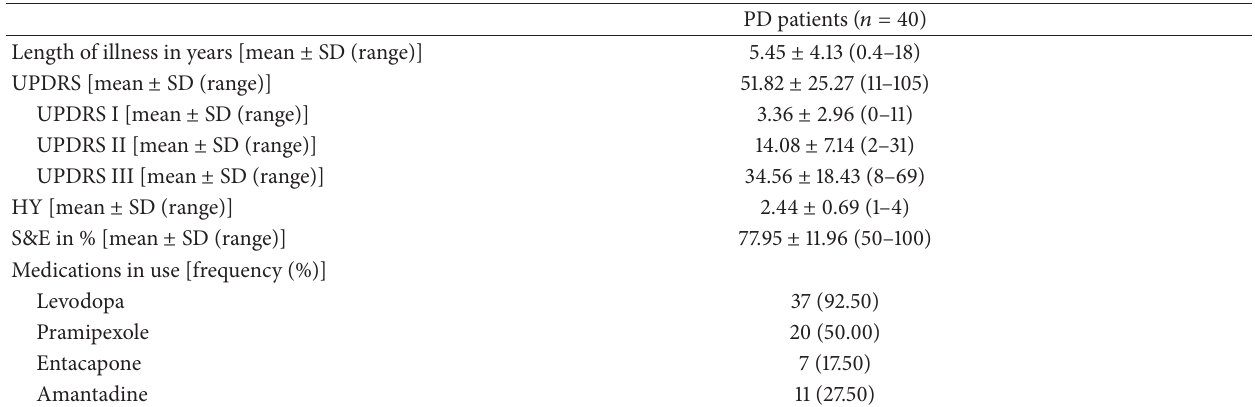
Table 2: Clinical features of Parkinson’s disease (PD) patients.